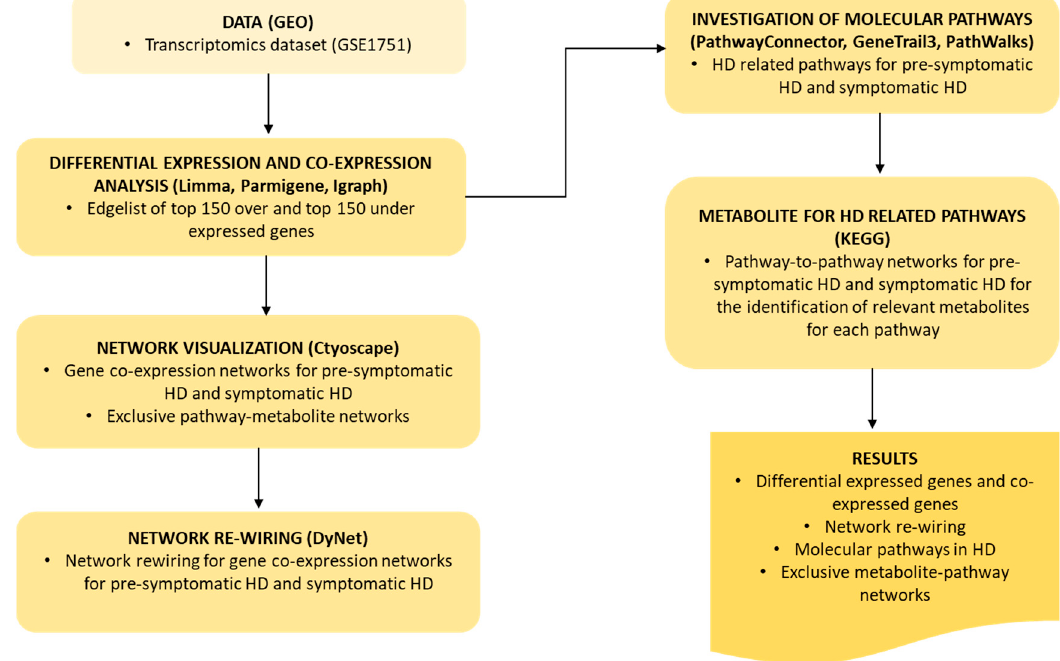
Figure 7. Flowchart of methodology and results.